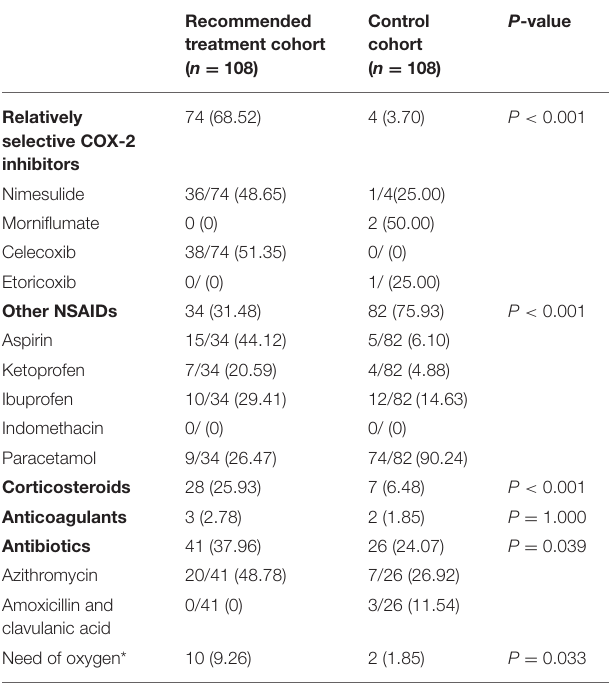
TABLE 3 | Treatment at home in the two study cohorts. TABLE 4 | Major secondary